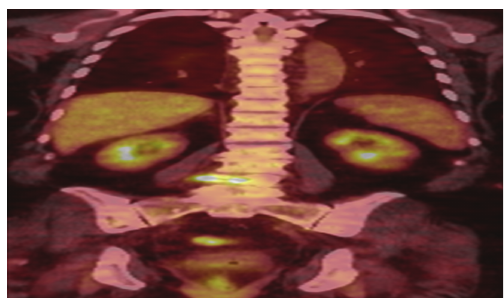
Figure 2: Coronal PET-CT scan. Hypermetabolic focus corre- sponding to the lumbar